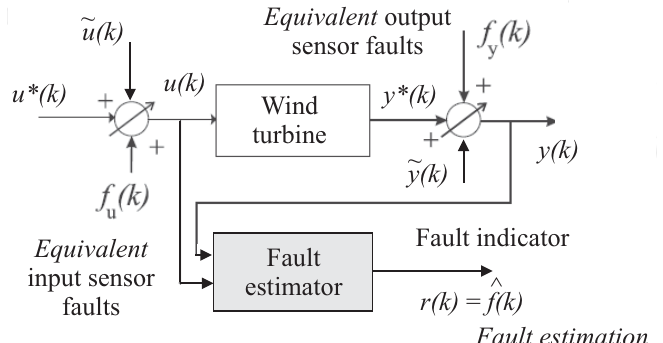
Figure 2. The residual generation scheme.